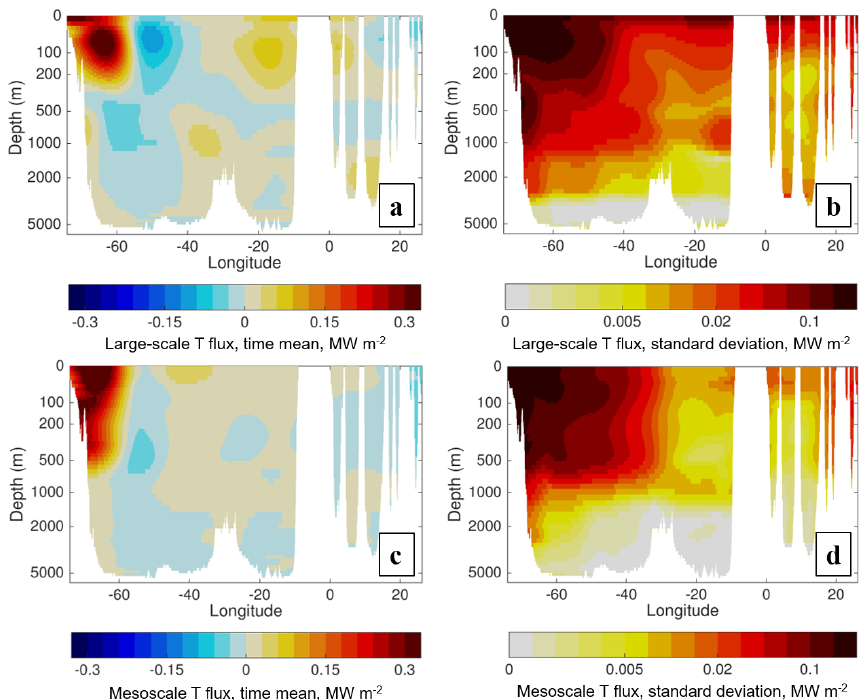
Figure 6. (a) Time-mean and (b) ID standard deviation of the zonally smoothed large-scale temperature flux. Zonal smoother is the low-pass filter in Eq. (4) with λ 0 = 20 ◦ longitude and s = 2. Panels (c, d) are the same as (a) , (b) but for the zonally smoothed mesoscale temperature